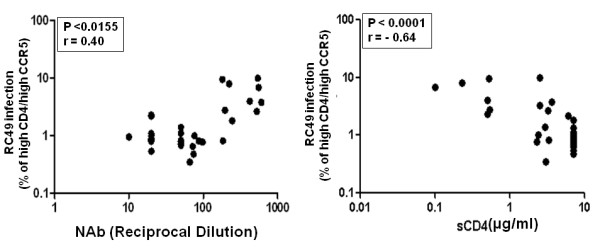
Correlation between CD4 dependence of patient Envs with their sensitivities to autologous plasma antibodies and sCD4. Association of CD4 usage of Env-pseudotyped viruses with autologous plasma antibodies and (P < 0.0155) and sCD4 (P < 0.0001) indicated that Env-pseudotyped viruses with low CD4 dependence tend to be more susceptible to autologous NAb in the patients tested here.